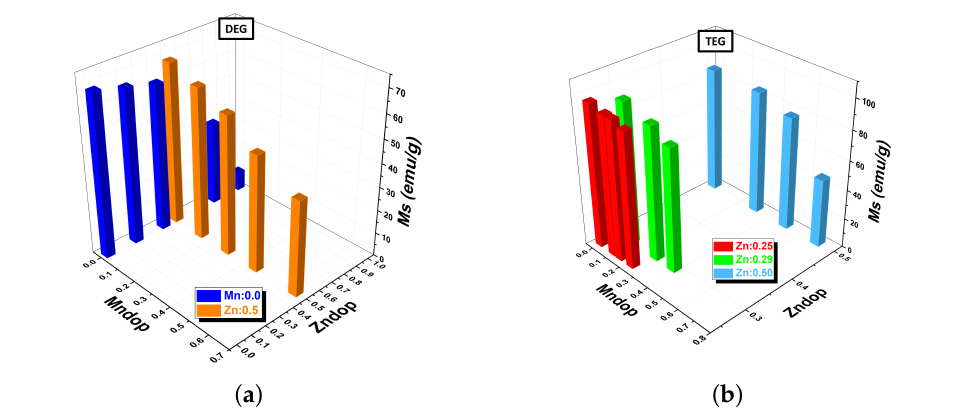
Figure 4. Variation of the saturation magnetization as function of zinc and manganese doping for the samples synthesized with ( a ) DEG and ( b ) TEG.